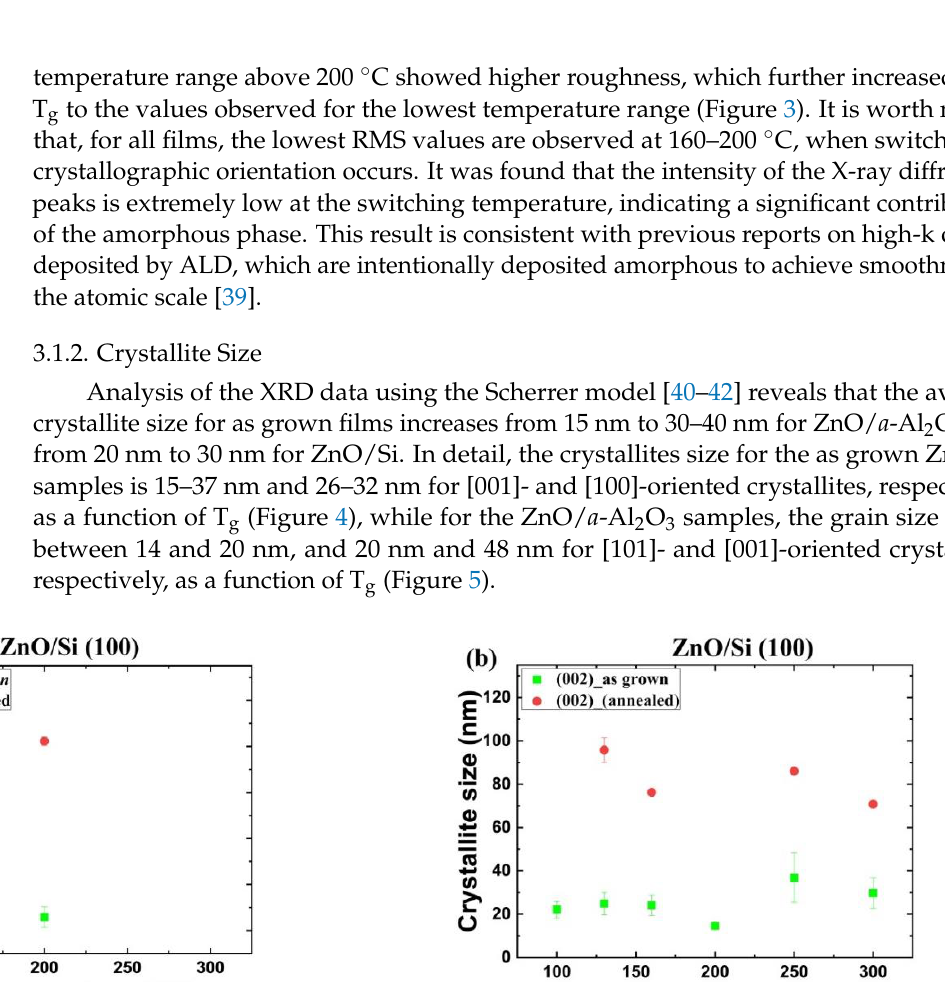
Materials 2021 , 14 , x FOR PEER REVIEW 7 of 21 Figure 3. ( a ) Atomic force microscope (AFM) images of as grown (1,2) and annealed (3,4) thin ALD